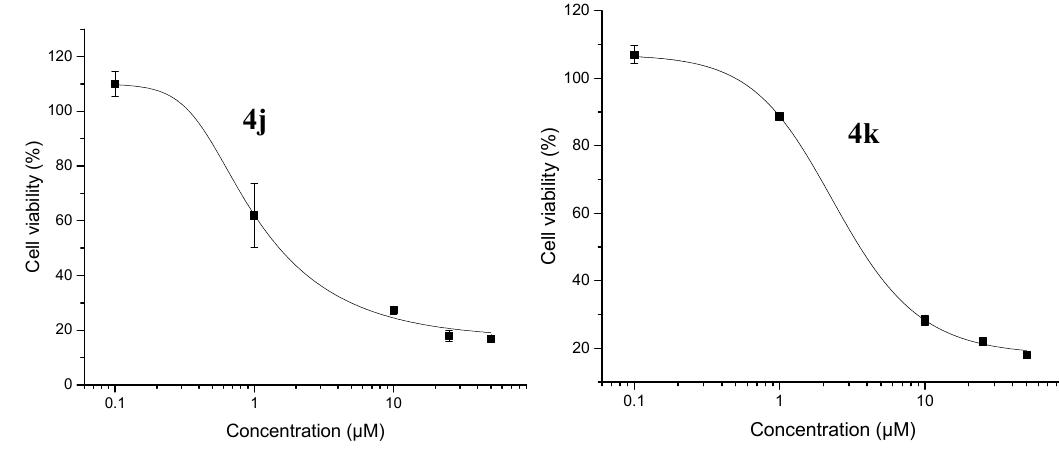
Figure 2. Dose–response curve of the most cytotoxic compounds against MCF7 cell lines.